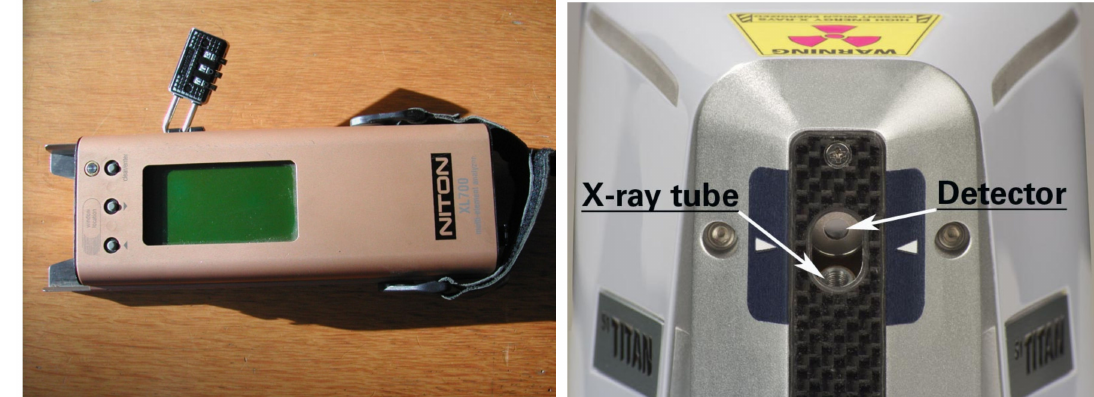
Figure 1. An early radioactive source portable X-ray fluorescence spectroscopy (pXRF) spectrometer (XLt723KWY), and the front part of a modern instrument (image courtesy of